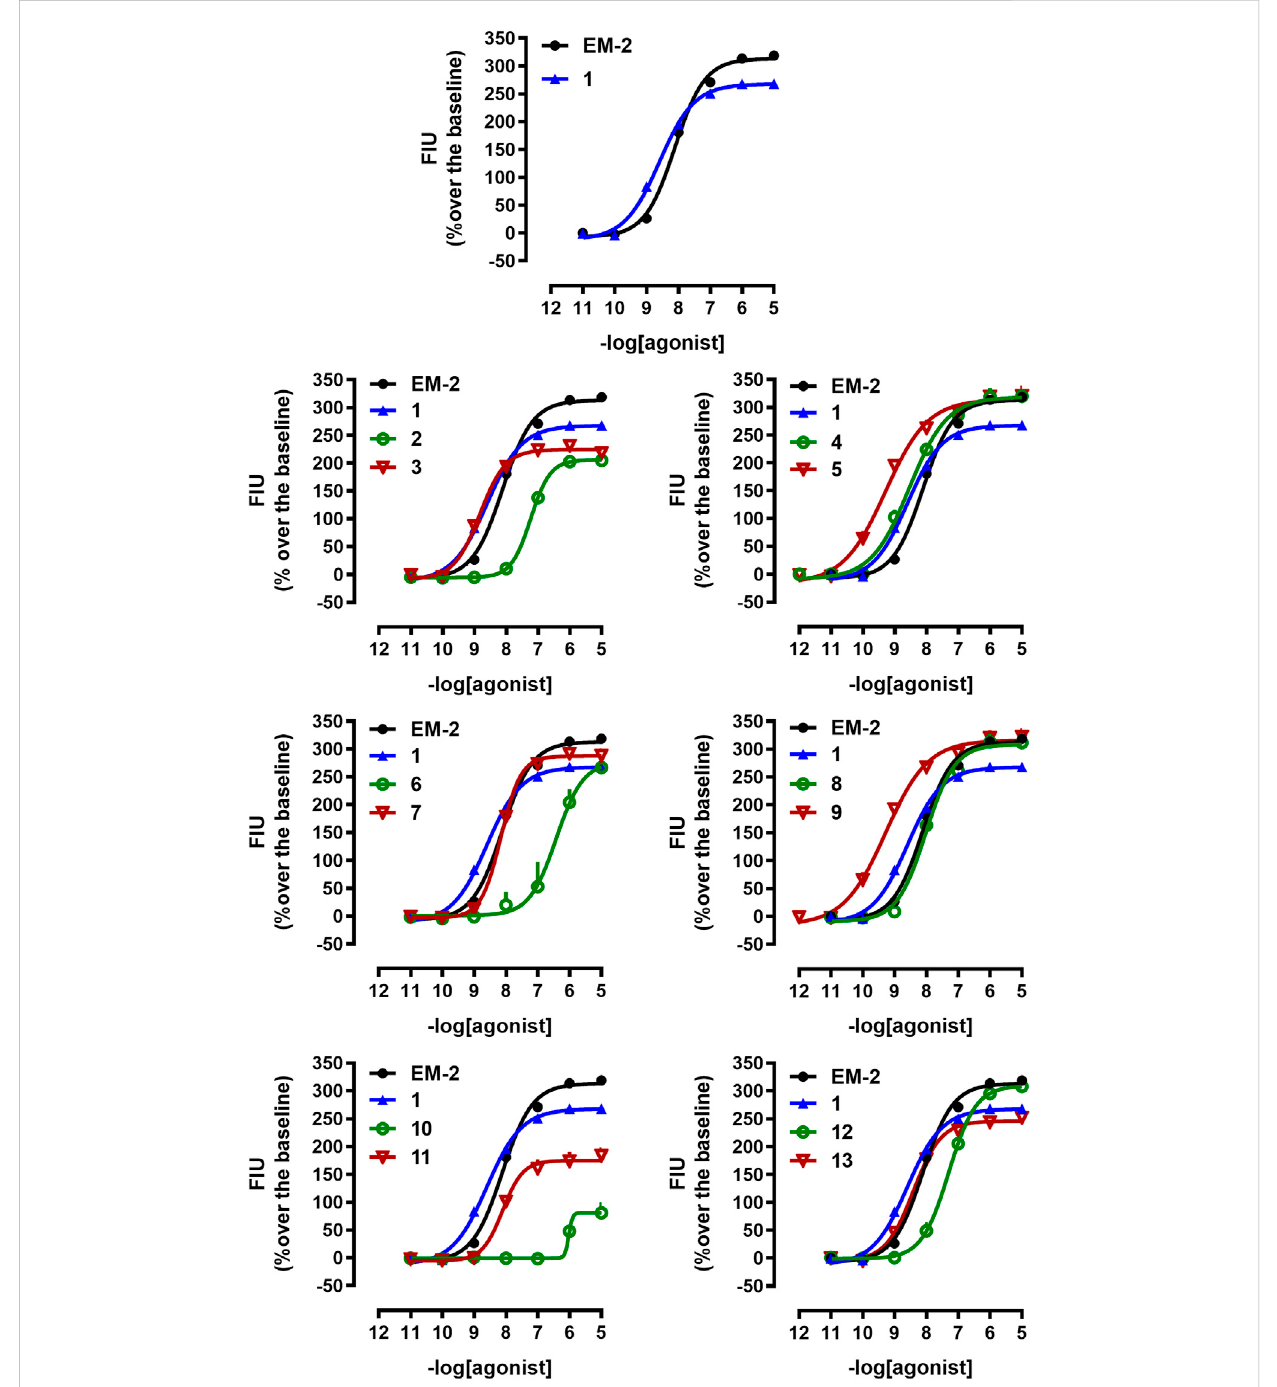
FIGURE 1 Calcium mobilization experiments at mu receptor. Concentration response curves to standard ( EM-2 ) and tested compounds ( 1 – 13 ) in calcium mobilization experiments performed in CHO mu cells stably expressing the G α qi5 protein. Data are the mean ± SEM of at least 5 separate experiments performed in